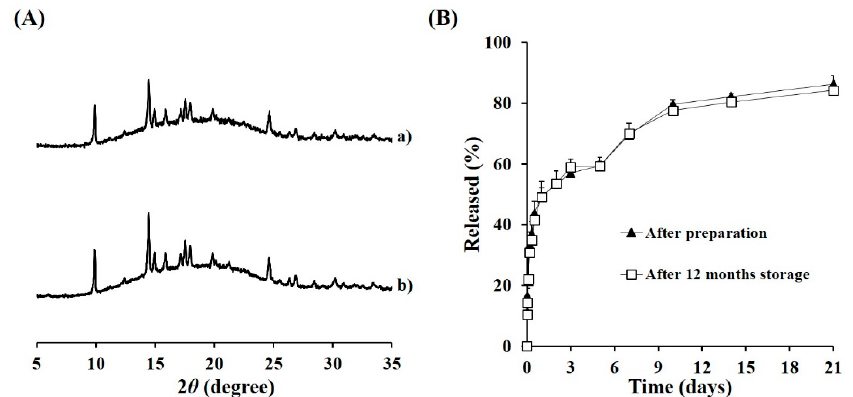
Figure A1. Physicochemical stability of TA microcrystals-loaded MS (F4) after 12 months of storage under ambient conditions. ( A ) XRD patterns of F4 MS (a) after preparation and (b) after 12 months of storage, ( B ) in vitro release profile of F4 after preparation and after 12 months storage under accelerated conditions; Notes: XRD pattern and release profile of F4 MS after preparation are identical to those depicted in Figures 2D and 3B, respectively. Each point in ( B ) in vitro release profile represents mean ± SD ( n =